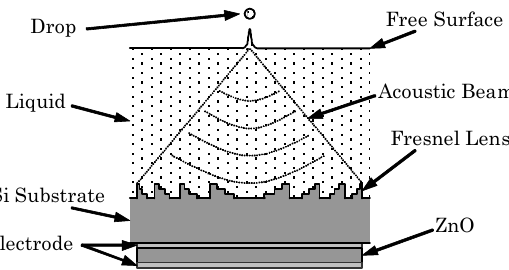
Fig.1 Head Structure Cross Section